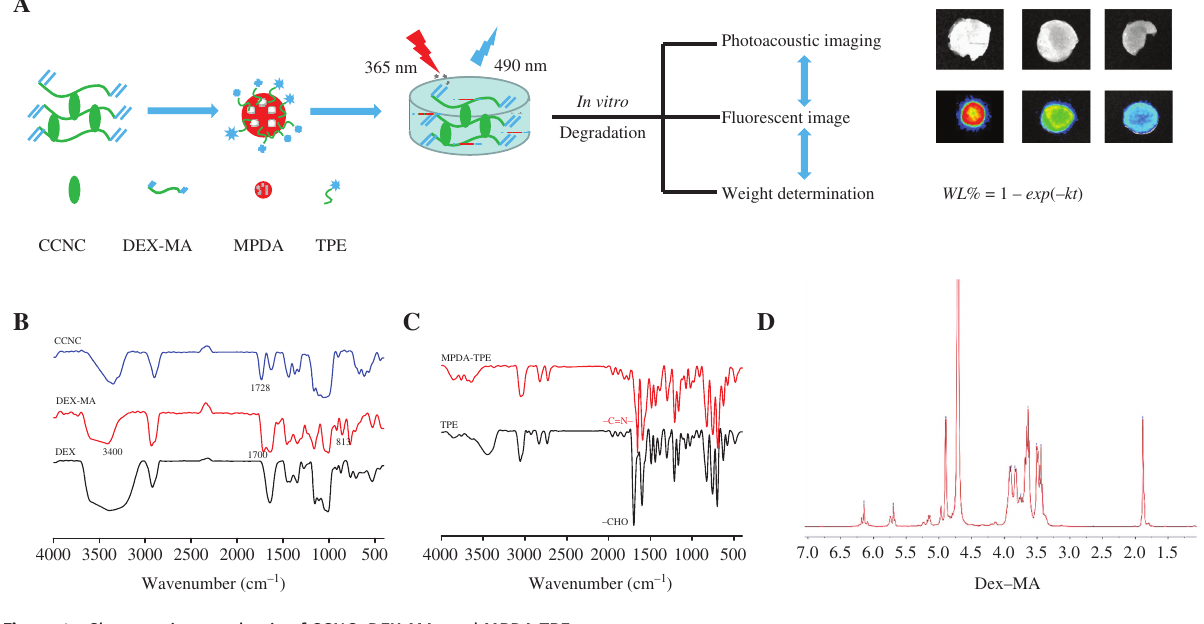
Figure 1: Charactering synthesis of CCNC, DEX-MA, and MPDA-TPE. (A) Schematic illustration of visual in vitro degradation of injectable hydrogel. FTIR of (B) CCNC, DEX, and DEX-MA and (C) MPDA and MPDA- TPE. (D) 1 H-NMR spectrum of DEX-MA in D 2